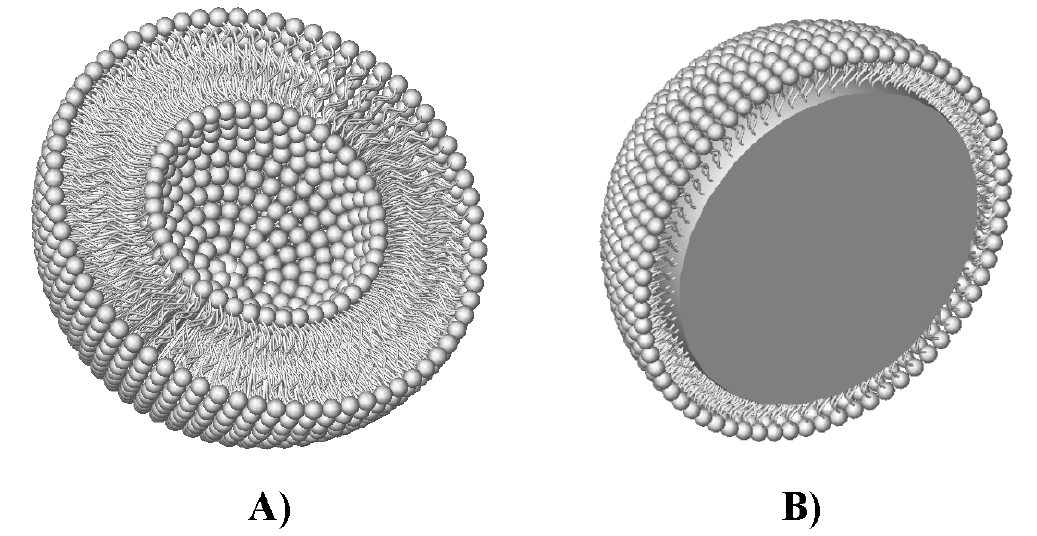
Figure 1. Colloids used for detoxification, including (a) unilamellar liposomes, comprised of a lipid bilayer composed of phospholipids surrounding an aqueous core, and (b) microemulsions or nanocapsules, which include an oily core stabilized by either phospholipids or